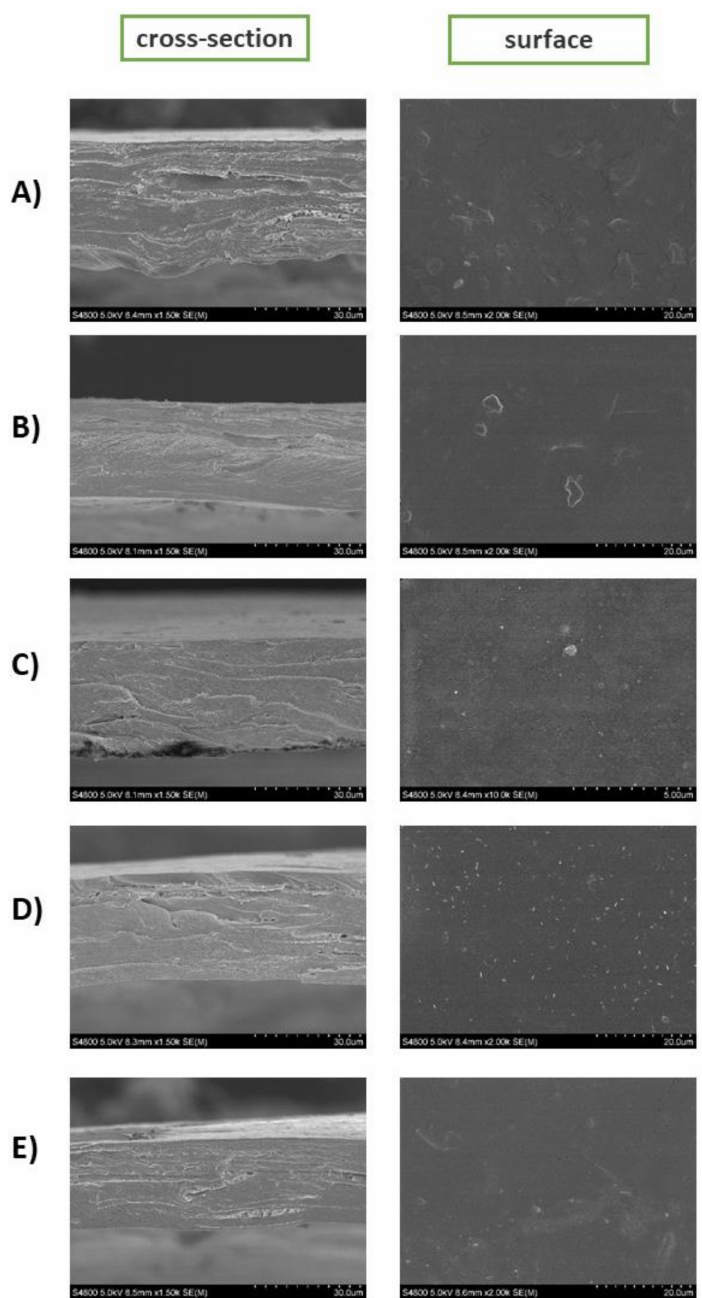
Figure 5. Cross-section and surface images of scanning electron microscopy of ( A ) CSNF; ( B ) CSNF- F1; ( C ) CSNF-F2; ( D ) CSNF-F3; ( E ) CSNF-OM